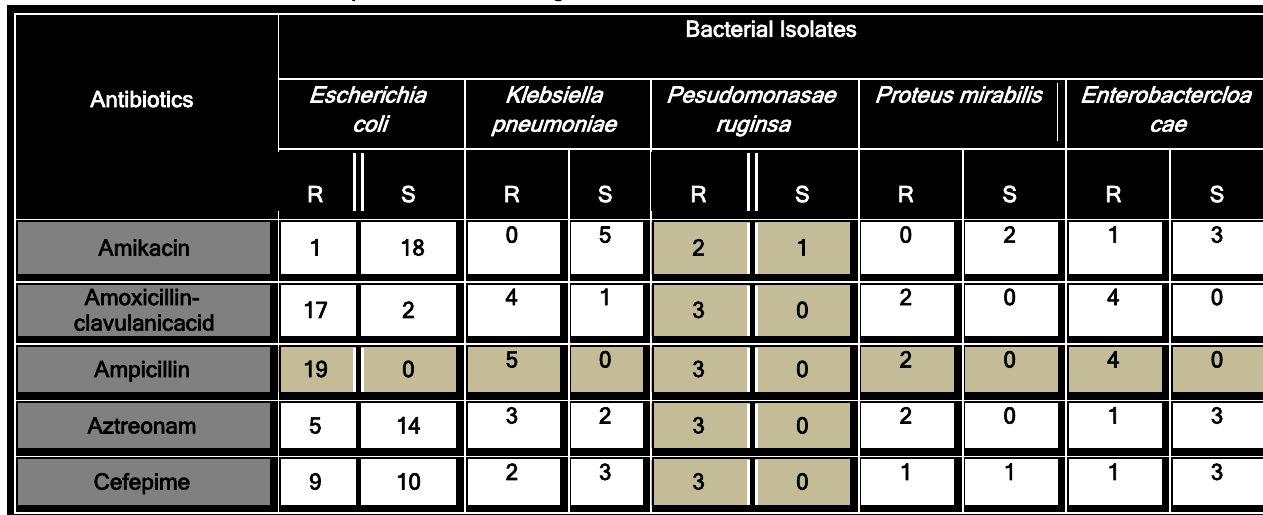
Table -3: Antimicrobial resistance patterns forGram negative